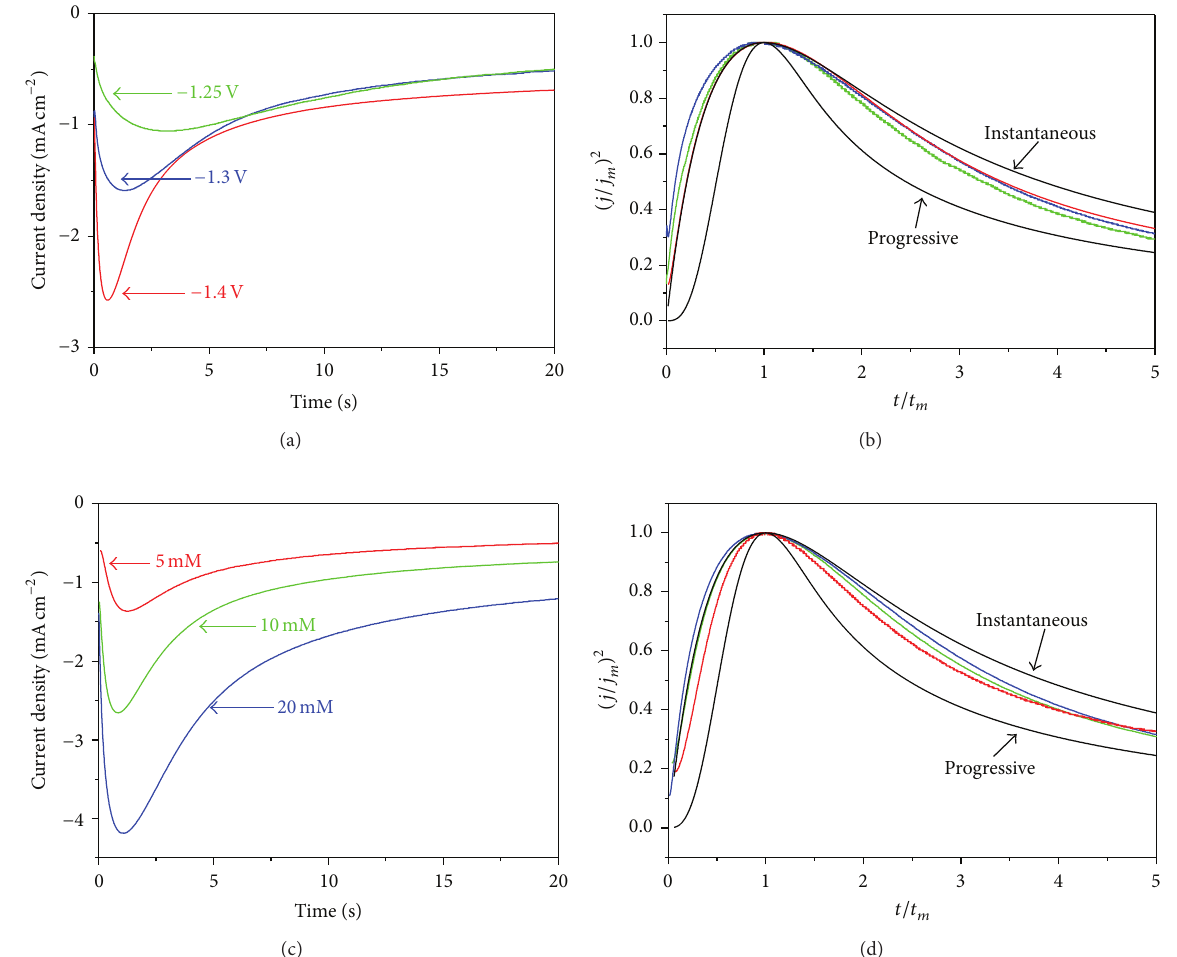
Figure 7: Potentiostatic current transients for Zn electrodeposition on GaN. (a) The concentration of ZnSO 4 was 10 mM and the potential was varied. (c) The applied potential was − 1.4 V, while the concentration of ZnSO 4 was varied. (b) and (d) are the corresponding nondimensional plots of (𝑗/𝑗 𝑚 ) 2 versus (𝑡/𝑡 𝑚 )